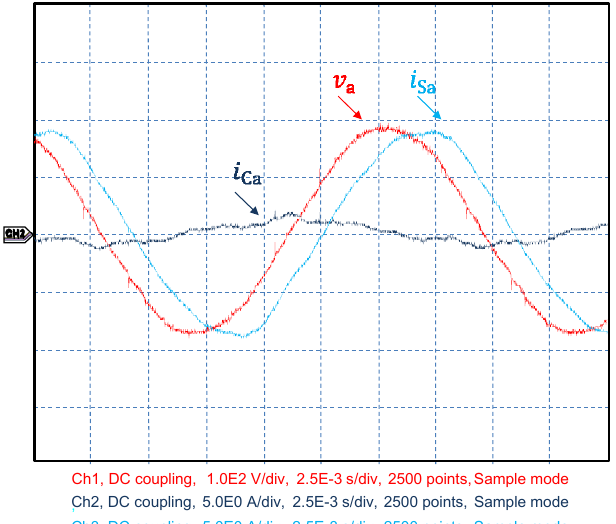
Figure 9. Experimental results—power factor control turned off.